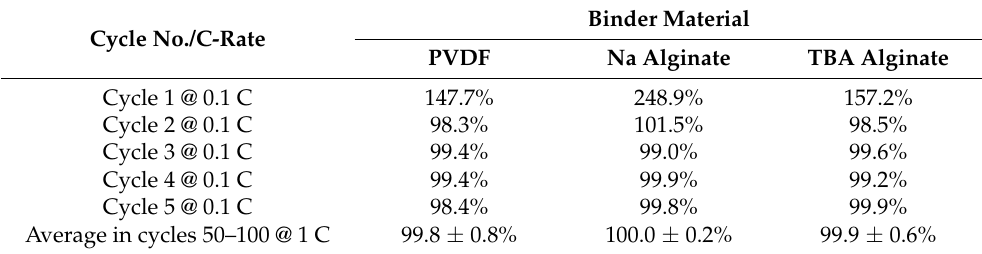
Table 1. Coulombic efficiency as a function of cycle and binder